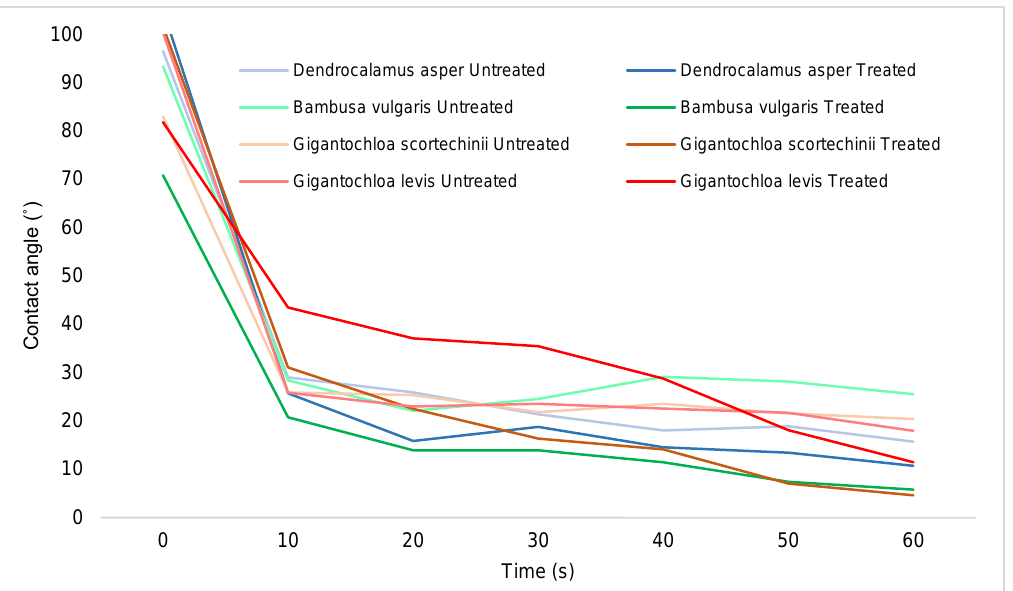
Figure 6. Changes in the contact angle of untreated and treated bamboo strips for four selected species.